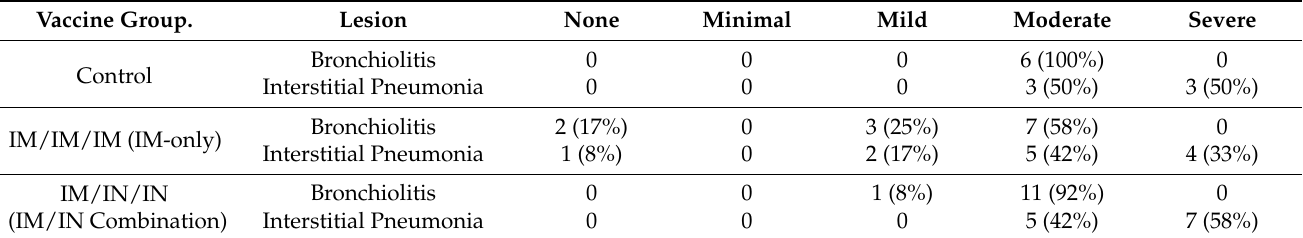
Table 1. Histopathologic Lesions Summary. Numbers indicate the absolute number of animals from the respective vaccine group that fall into each category (lesion and severity) while the parentheses indicate overall percentage of animals from said vaccine group that fall in the category.